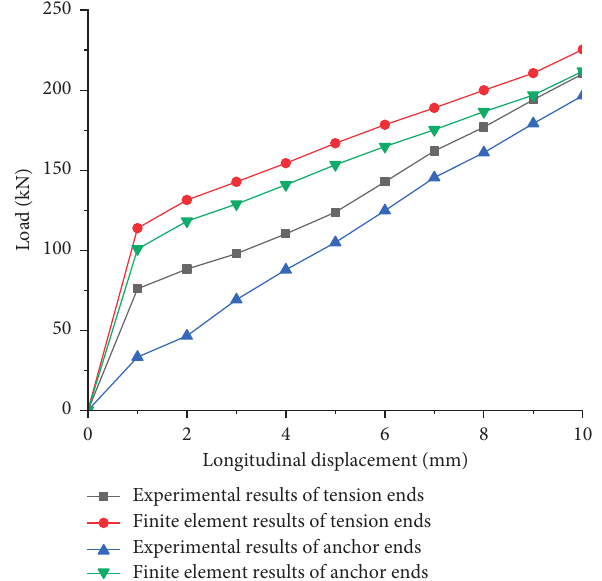
Experimental results of anchor ends Finite element results of anchor ends Figure 14: Comparison of experimental and finite element